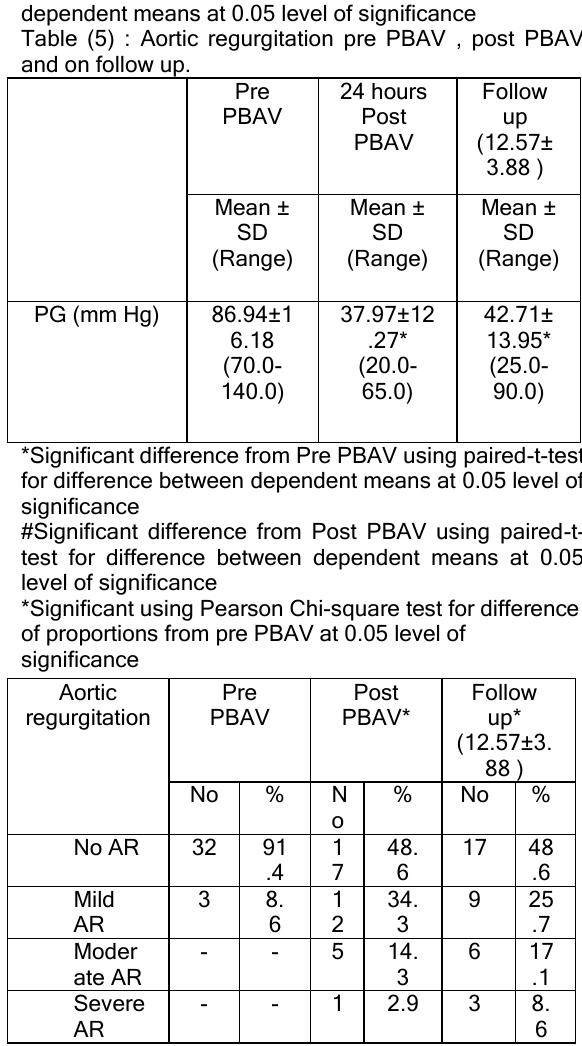
Table (6 ) : The annulus & balloon sizes with balloon/annulus ratio of the studied